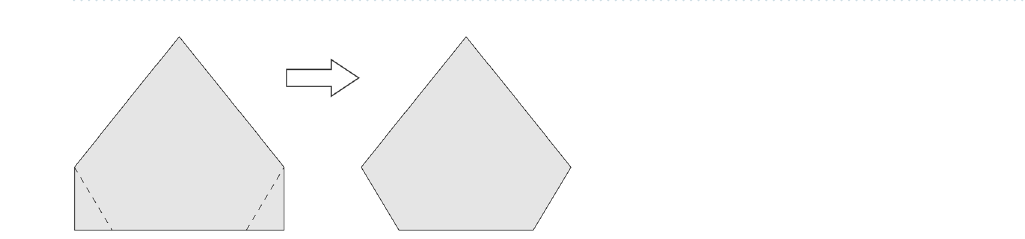
Figure 8. Prototype 8 in a top wing configuration aircraft model.